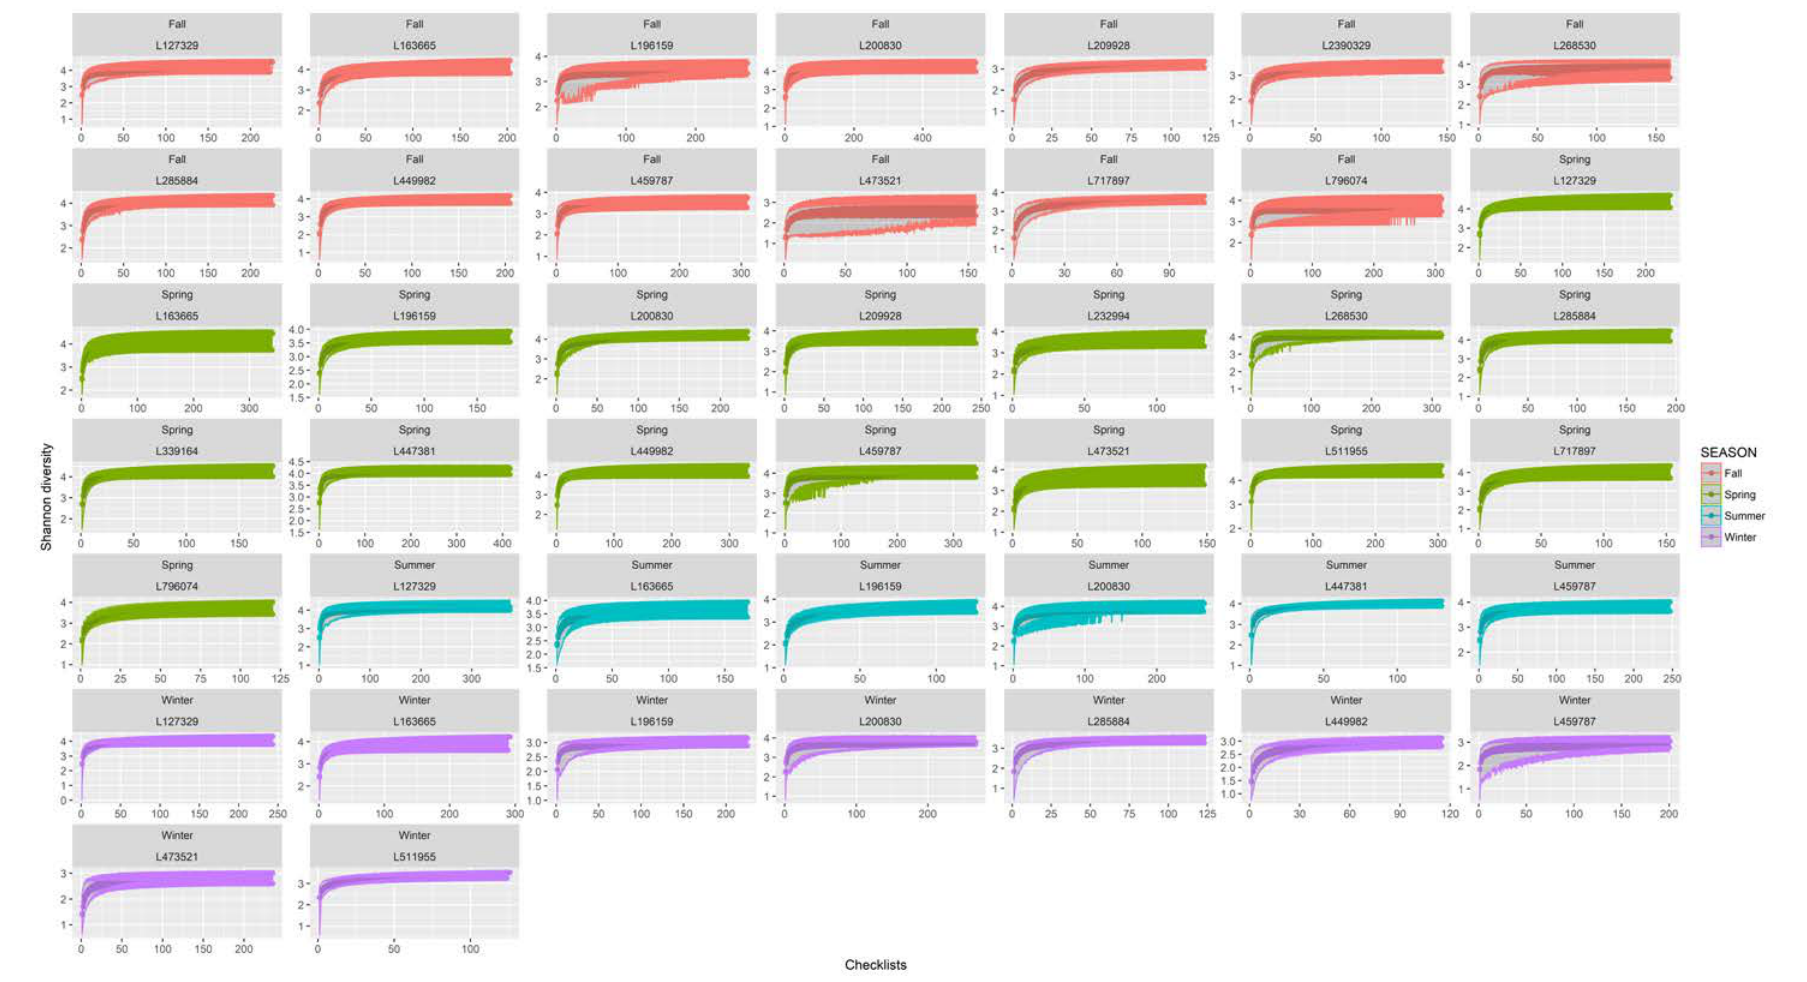
Figure A2.5. Species diversity accumulation curves for each hotspot/season combination that had >100